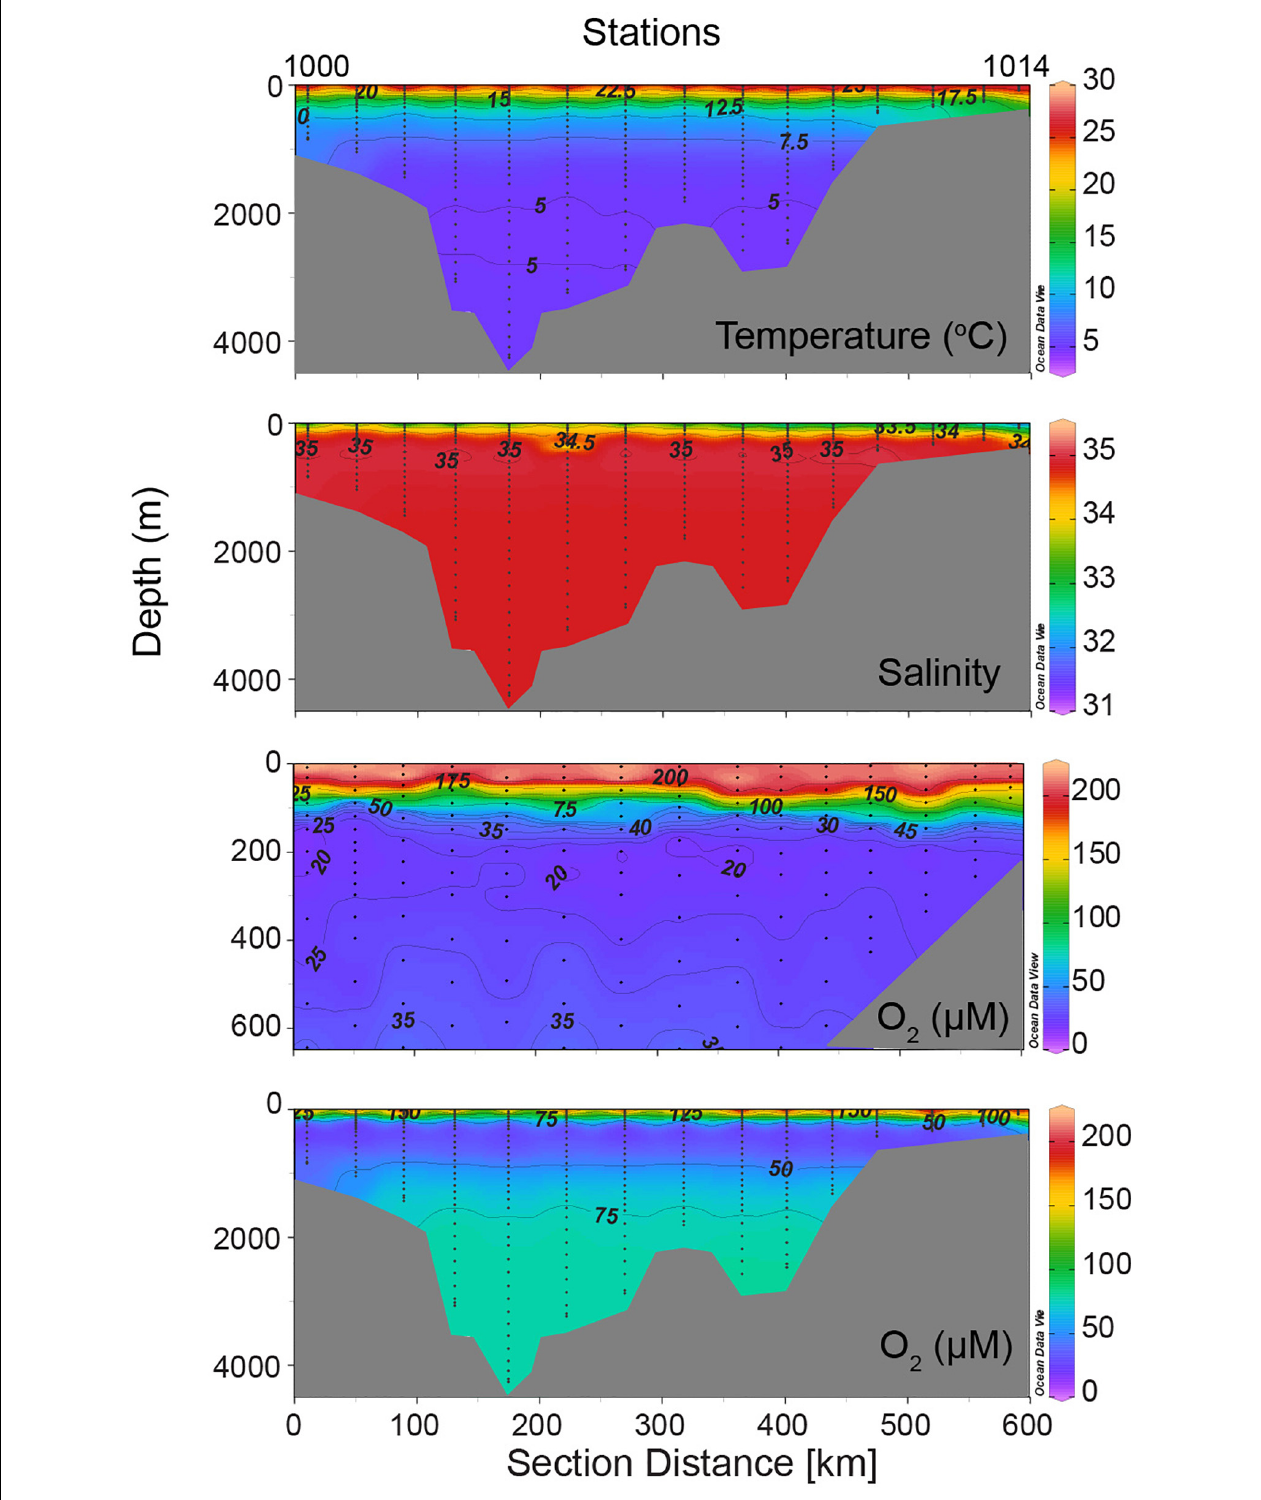
FIGURE 5 | Vertical sections of temperature, salinity, and dissolved oxygen along ∼ 10 ◦ N (part of WOCE I01 Line) in the Andaman Sea constructed using data collected during the R.V. Knorr cruise in October 1995. These data form a subset of those presented in the WOCE Indian Ocean Atlas (Talley, 2013;